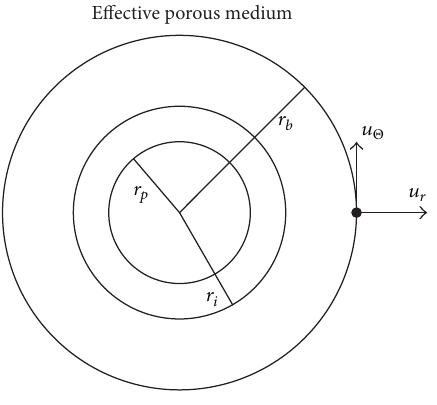
Figure 9: Composite sphere